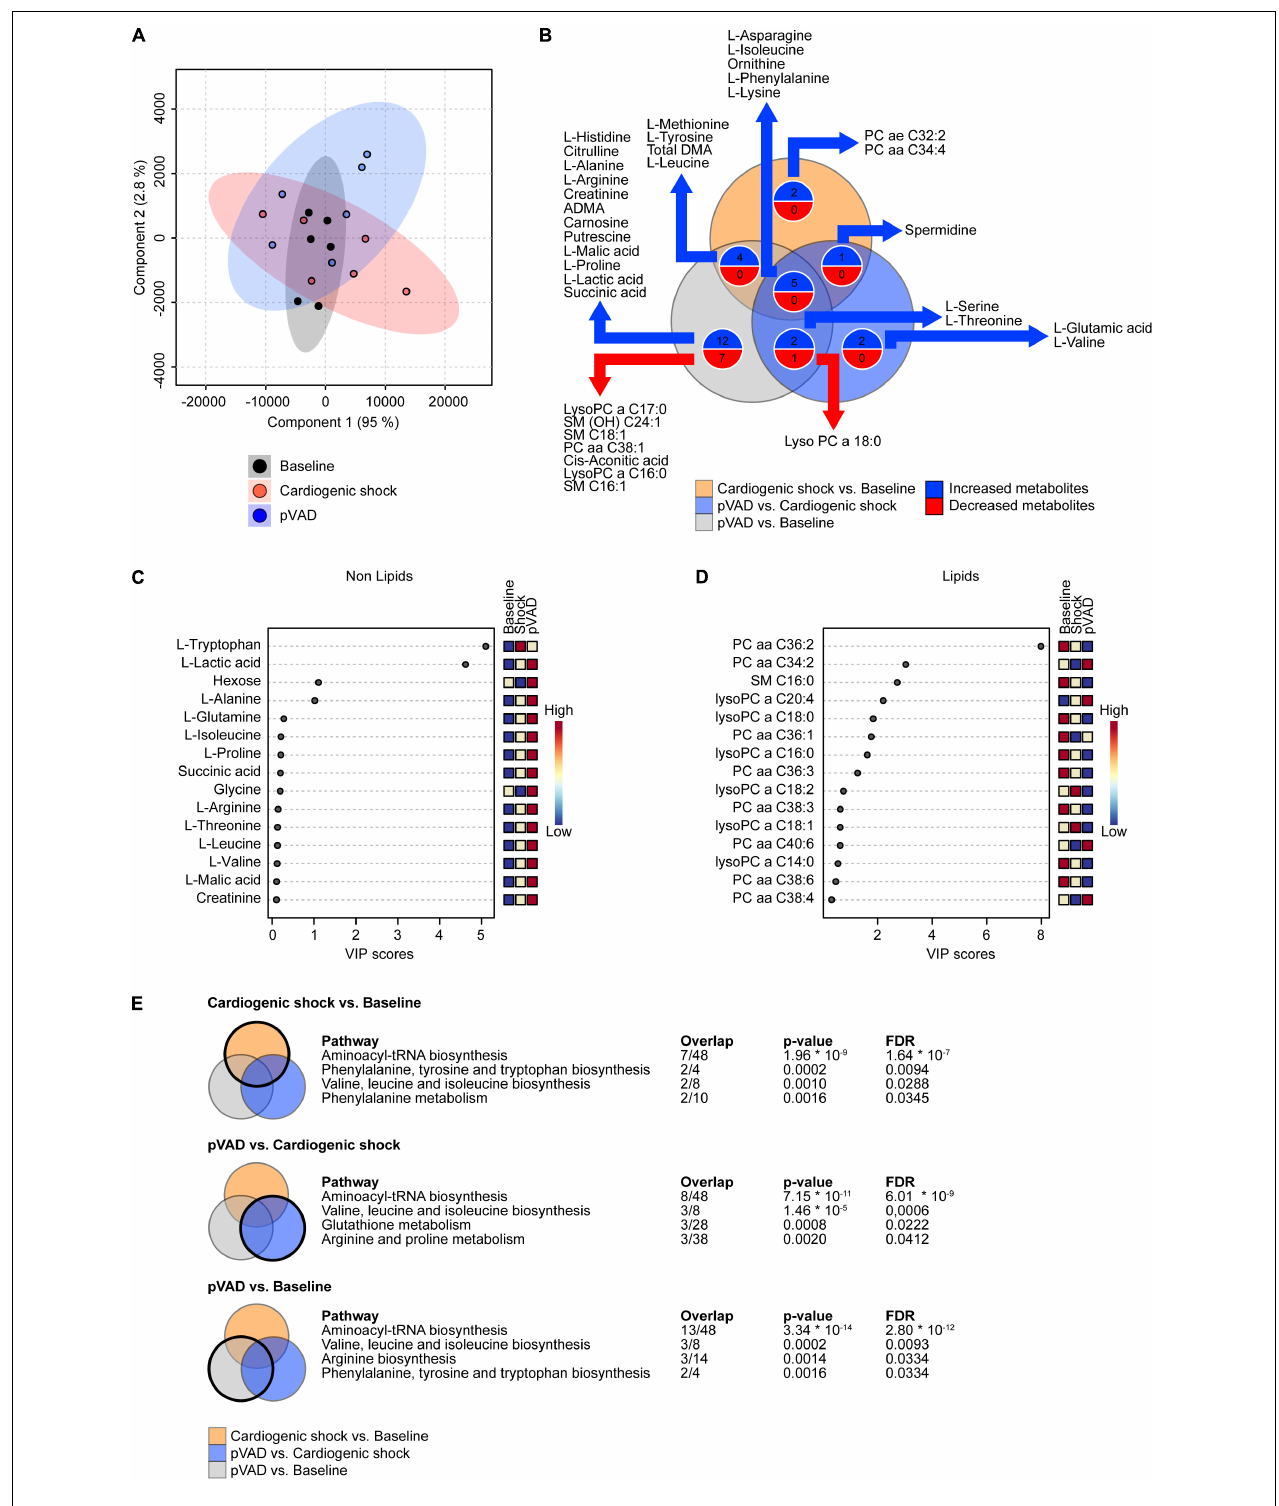
FIGURE 2 | Metabolomic profiling of serum. (A) Partial Least Squares-Discriminant Analysis (PLS-DA) visualizing global metabolite abundance. (B) Venn diagram illustrating the number of altered metabolites as determined by LC-MS and GC-MS metabolomic analysis. Numbers of metabolites presented in the Venn diagram correspond to p < 0.05. (C,D) Variable importance in projection (VIP) score analyses. (E) Significantly enriched pathways for the comparisons as indicated (cut-off: false discovery rate (FDR) p < 0.05); pVAD, percutaneous ventricular assist device.